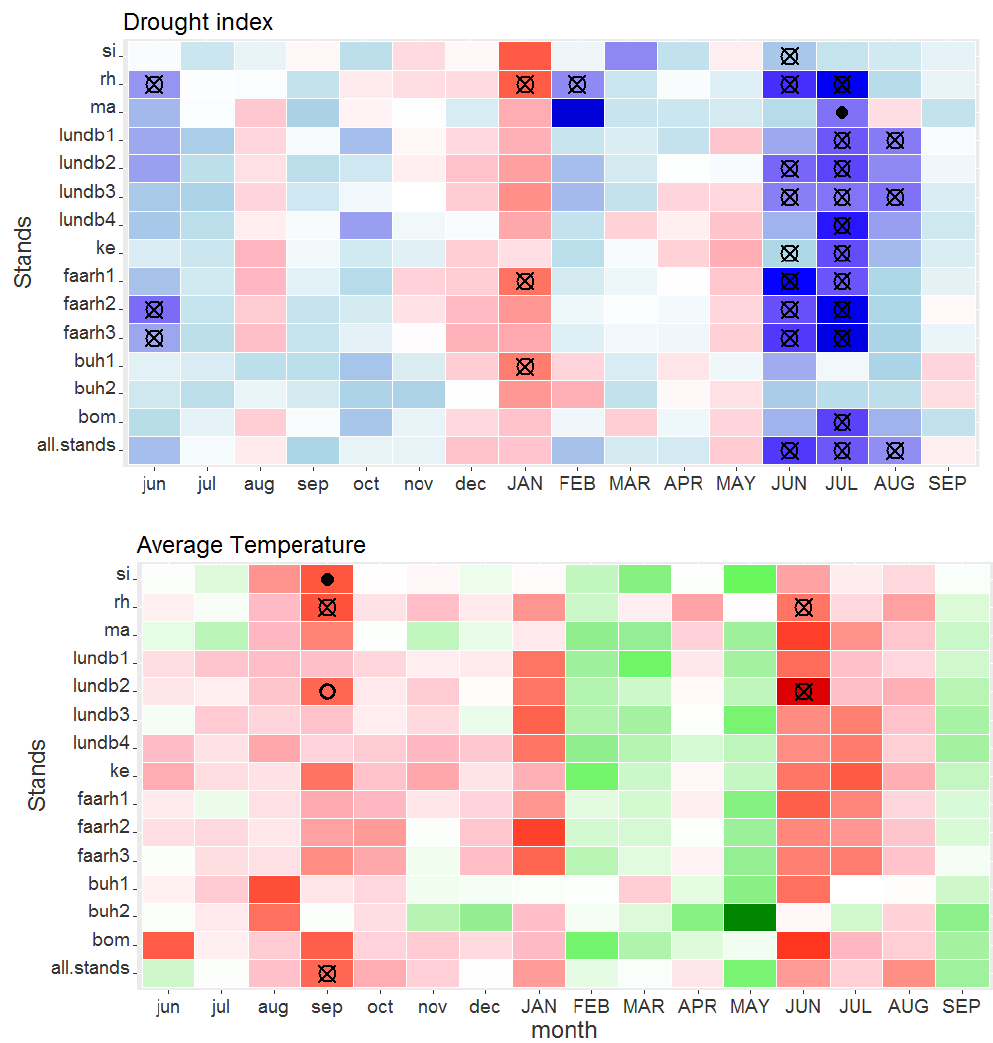
Figure 3. Bootstrapped response correlation coefficients between the tree-ring indexes and monthly drought index ( DI ) and monthly mean temperature ( Tg ) for the fourteen plantation stands (see Table 1 for stand codes). Months in capital letters indicate the current year of ring formation, and months in lower case refers to climate variables during the year preceding ring formation. Significant correlations are represented by black solid dot ( p < 0.05), black circle ( p < 0.01) and black circle with cross ( p < 0.001). Bootstrapped response correlation coefficients for the six field trials (e.g., 1008, 1009, 1010, 1011, 1013 and 1014) are referred to Huang et al. [9].